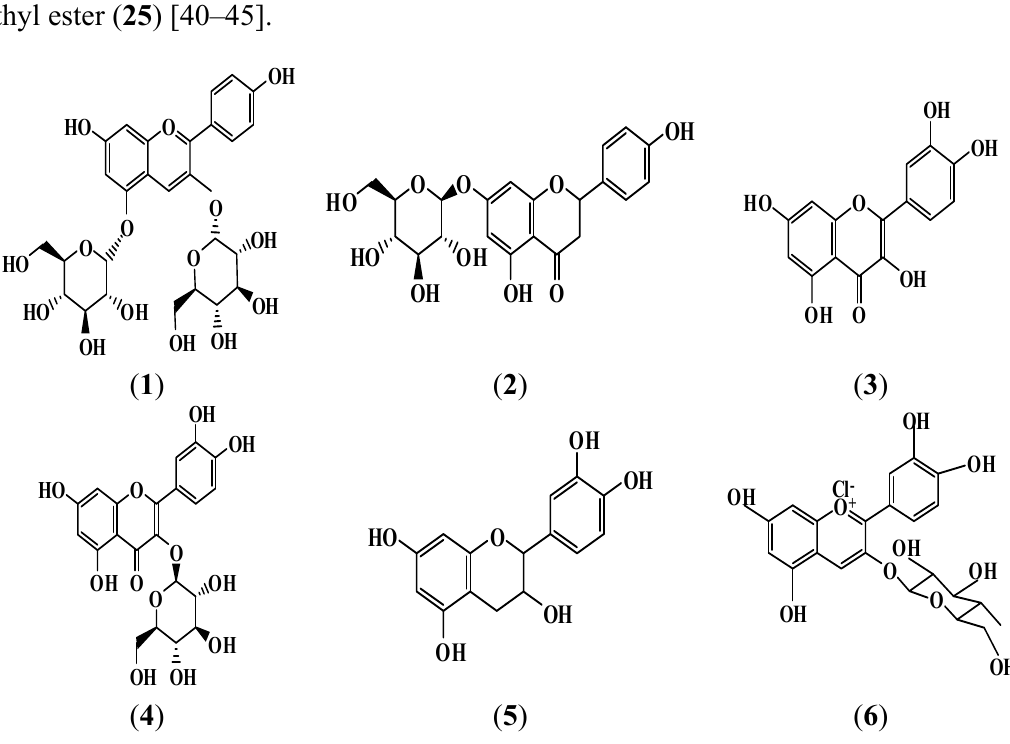
Figure 2. Compounds isolated from G. asiatica : Pelargonidin 3,5-diglucoside ( 1 ), Naringenin-7- O - β - D -glucoside ( 2 ), Quercetin ( 3 ), Quercetin 3- O - β - D -glucoside ( 4 ), Catechins ( 5 ), Cyanidin-3-glucoside ( 6 ), Grewinol ( 7 ), Naringenin ( 8 ), 3,21,24-trimethyl- 5,7-dihydroxy-hentriacontanoic acid δ lactone ( 9 ), Betulin ( 10 ), Lupeol ( 11 ), lupenone ( 12 ), Friedelin ( 13 ), α -Amyrin ( 14 ), β -amyrin ( 15 ), β -sitosterol ( 16 ), Lanost-9(11)-en-12-one ( 17 ), Docosanol ( 18 ), Nonacosanol ( 19 ), Stigmast-7-en-3-ol ( 20 ), Citric acid trimethyl ester ( 21 ), α -methyl-l-sorboside ( 22 ), stigmasterol ( 23 ) Campesterol ( 24 ), 9,12-octadecadienoic acid methyl ester ( 25 )